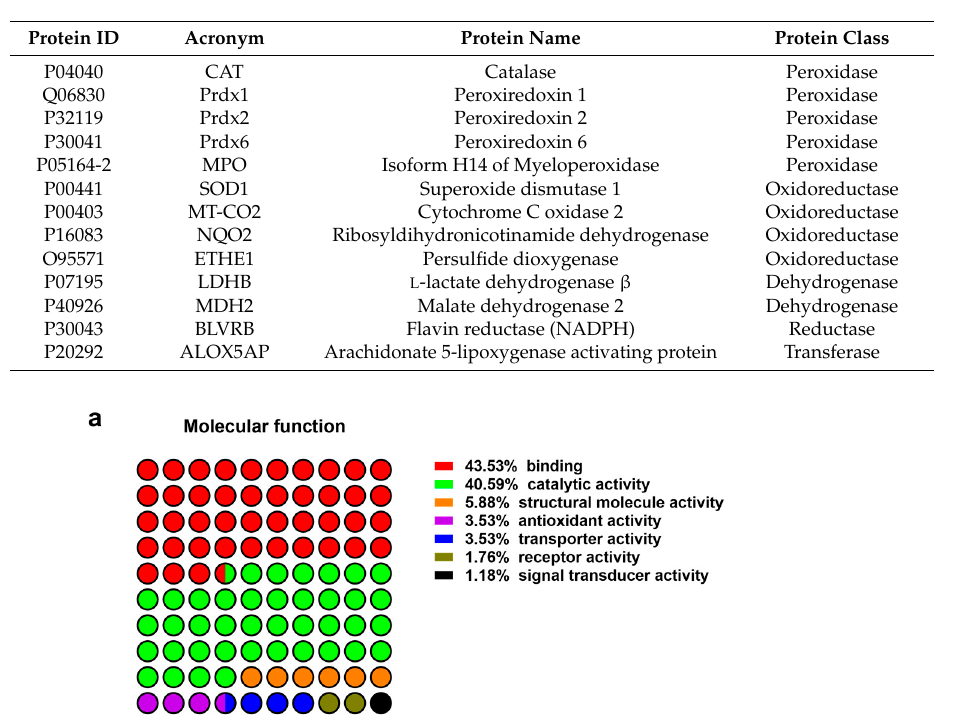
Table 2. Oxidoreductases in wound fluids.